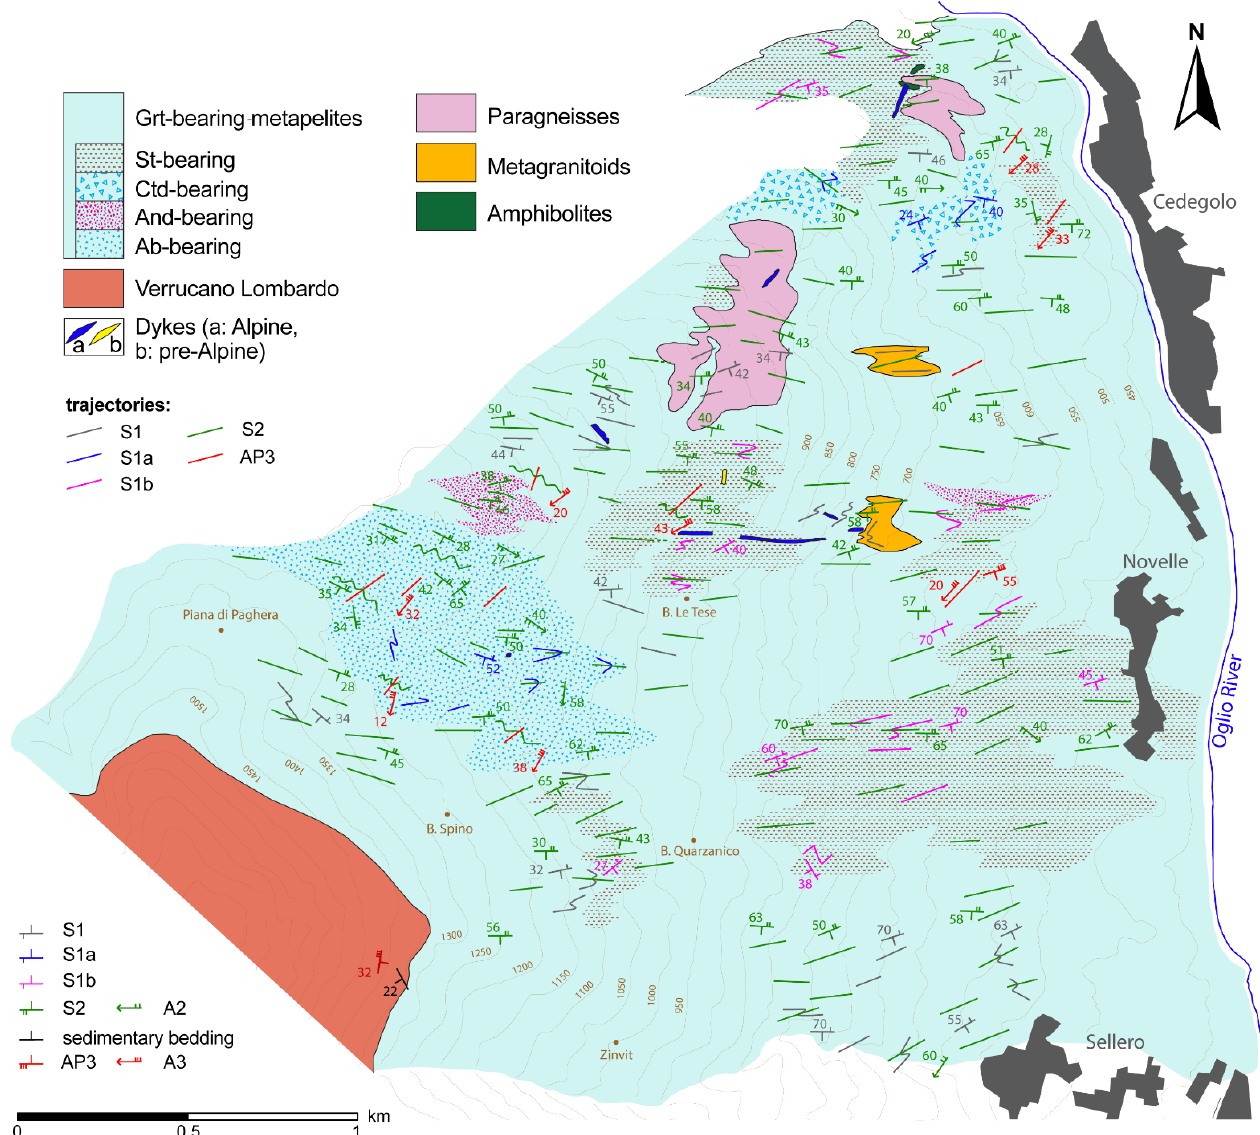
Figure 3. Interpretative structural map of the area west of Cedegolo and Sellero villages in the upper Val Camonica (location in Figure 2). Orientations of fabric elements synthesized in this foliation trajectory map are analytically shown in Figure 5. Urban areas are bounded by grey polygons.